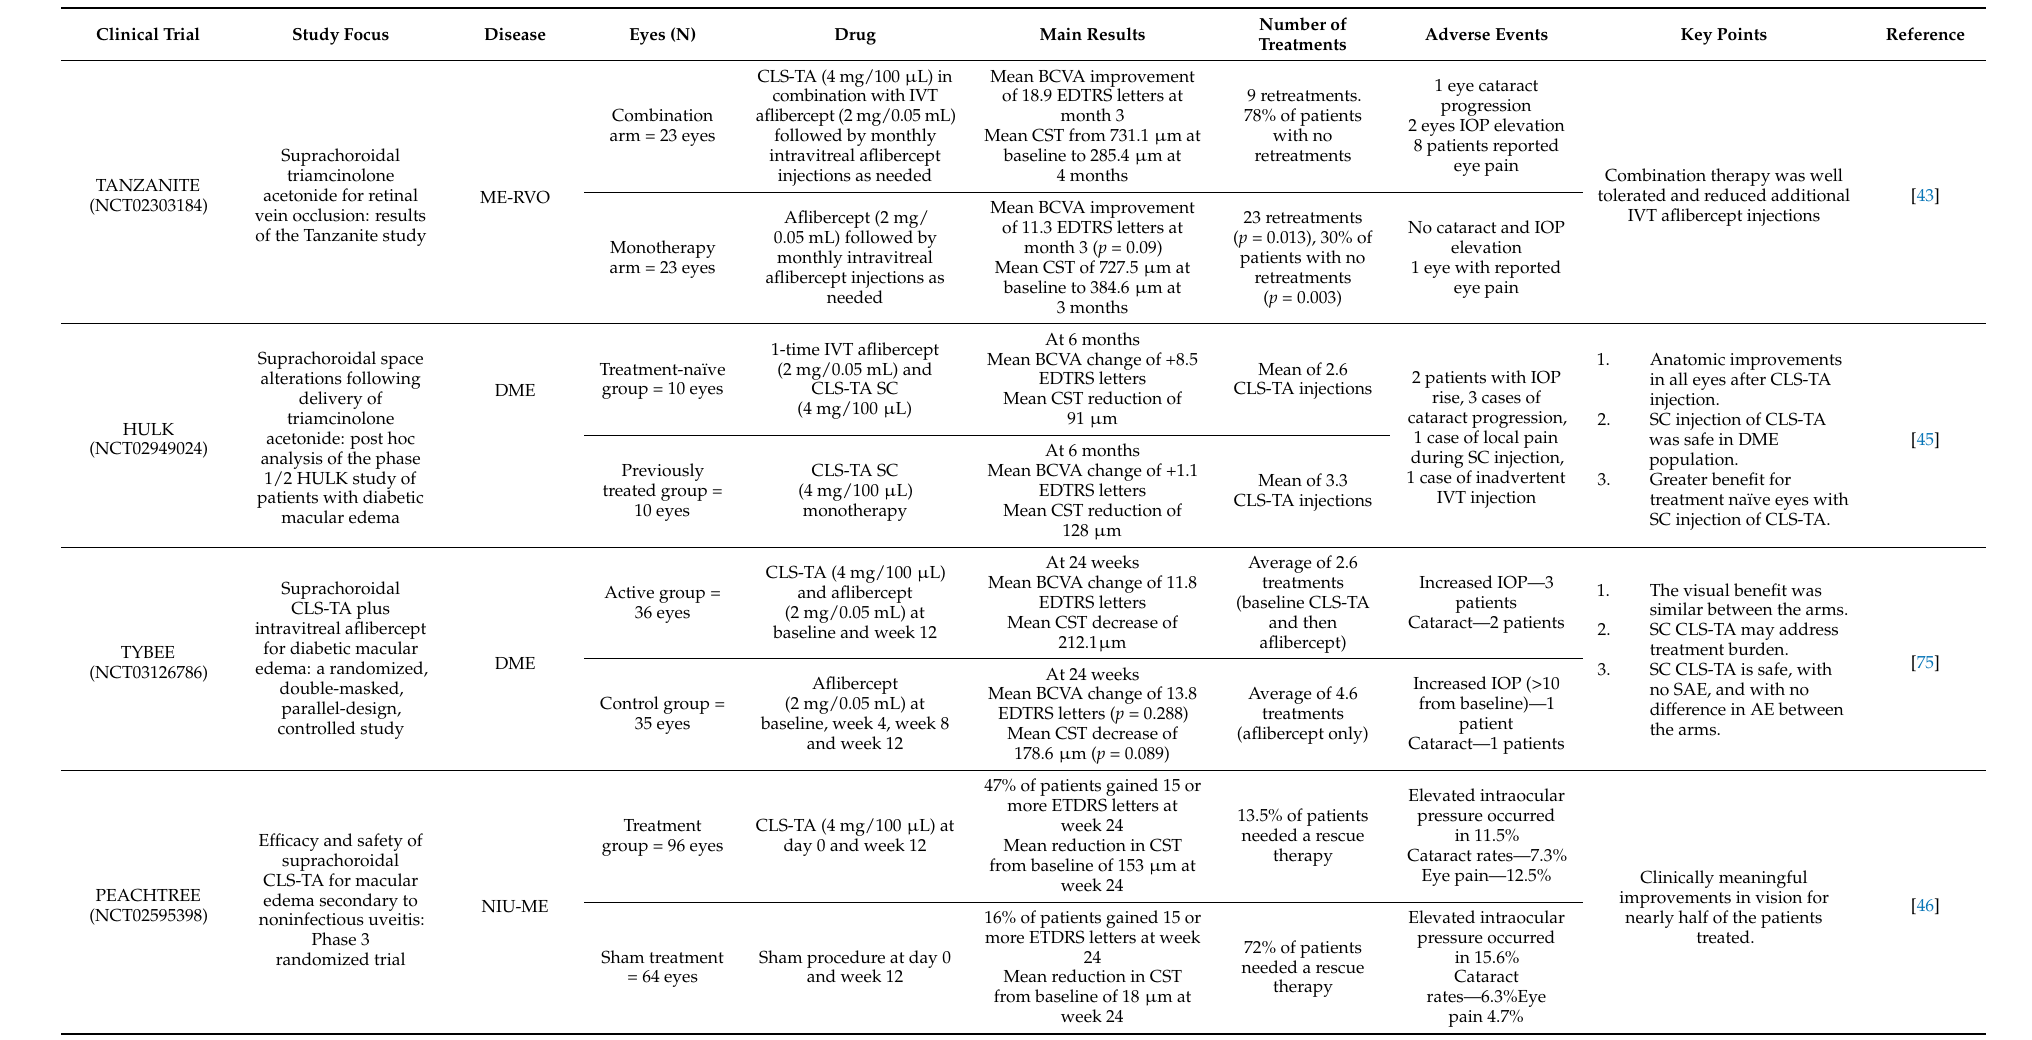
Table 1. SCS pharmacotherapies in human clinical